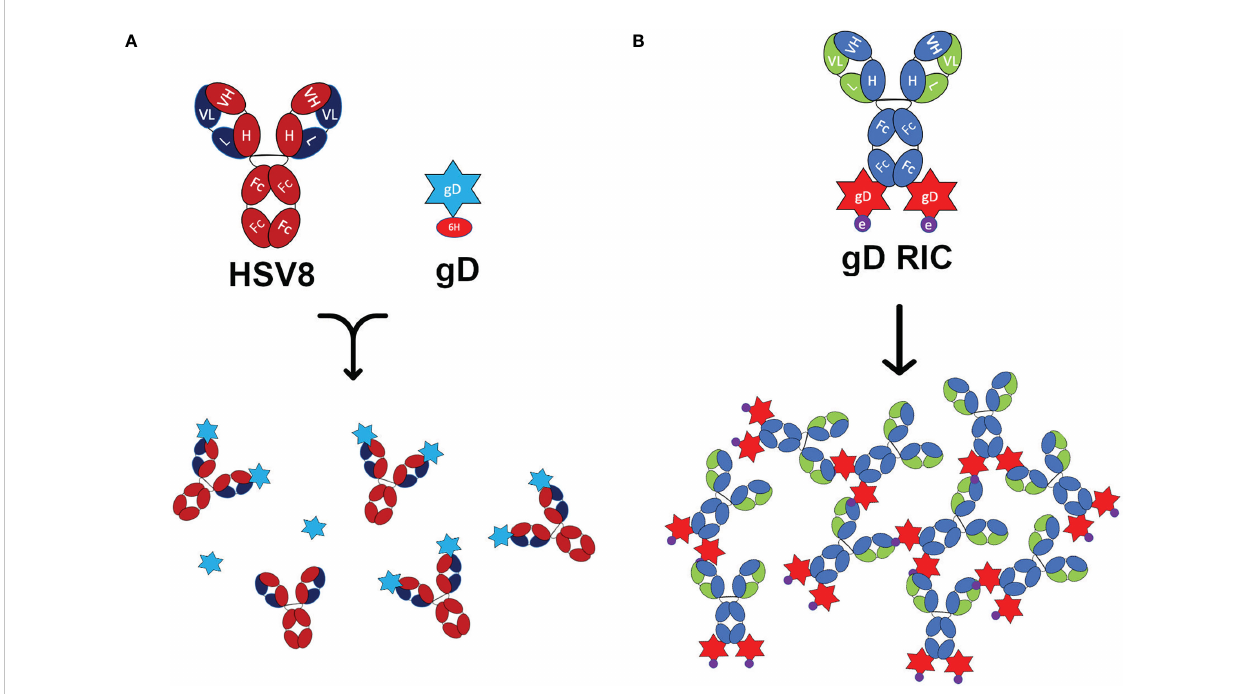
FIGURE 1 Schematic representation of the constructs used in this study. (A) Representations of the human IgG1 monoclonal antibody HSV8 and 6-histidine tagged glycoprotein D (gD) from HSV-2. When mixed, HSV8 can bind up to two gD molecules forming an immune complex (IC). (B) The recombinant immune complex (RIC) construct contains the 6D8 monoclonal antibody with C-terminal fusion to gD connected via linker with the epitope tag “ e. ” This construct forms self-binding clusters via the interaction of the 6D8 variable regions with the epitope tag “ e ” on another gD-RIC molecule. This interaction results in the formation of larger immune